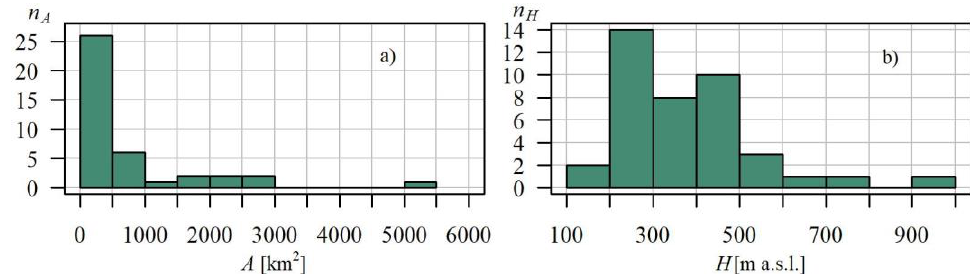
Figure 2. Plots show: ( a ) number of catchments versus catchment area A ; ( b ) number of catchments versus gauging station elevation H ; scales, in Polish Carpathian.